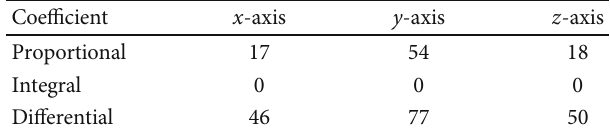
Table 1: The optimal PID coe ffi cient